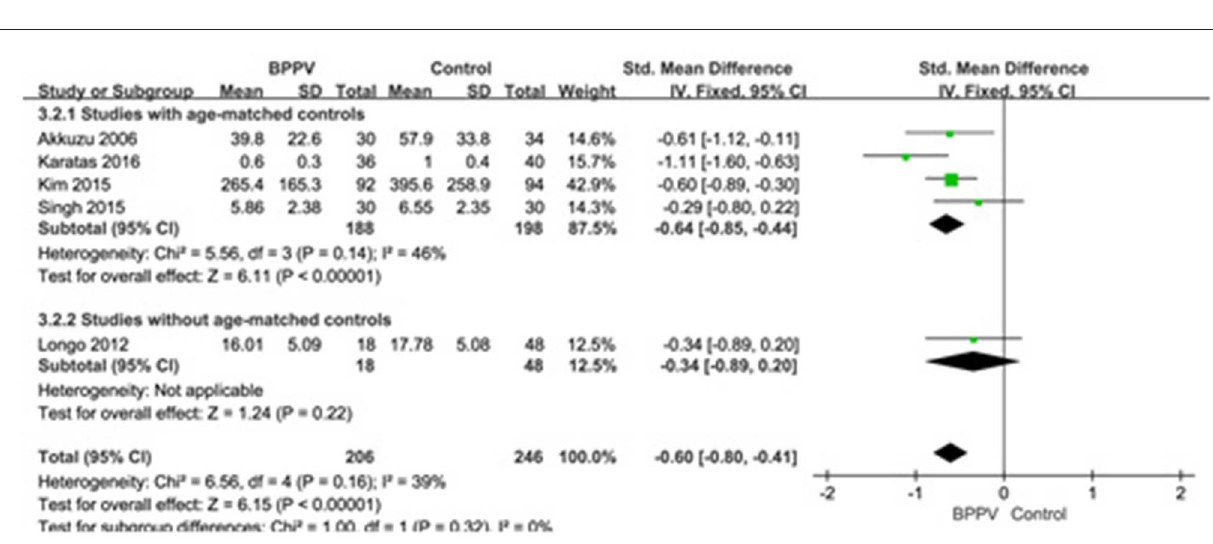
( p = 0.002, Figure 6 ) between the six studies with